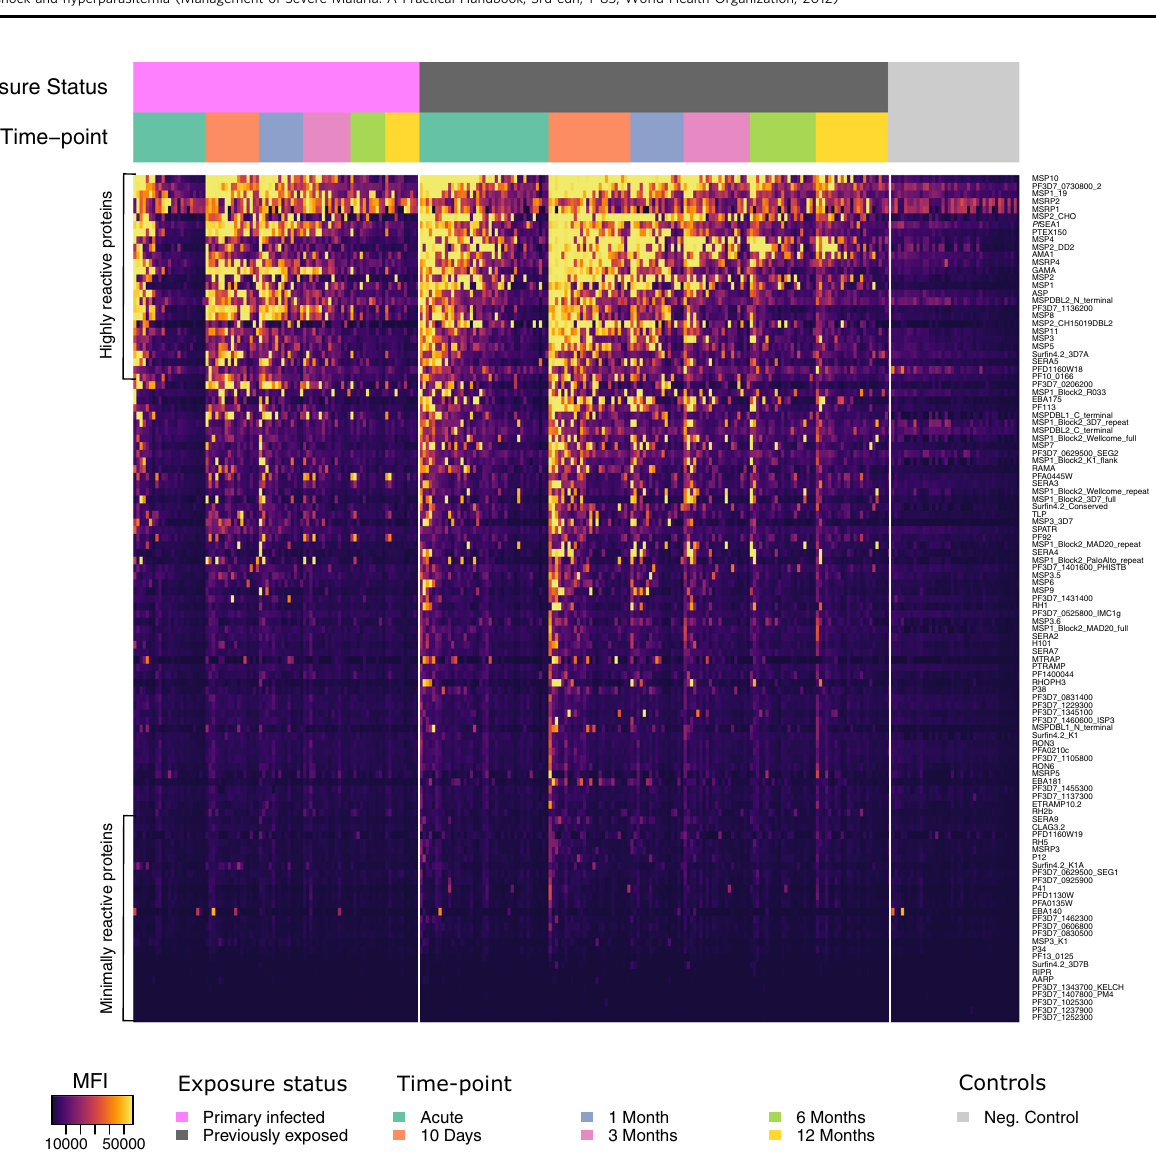
Fig. 1 A heat map of the normalised median fl uorescent intensity (MFI) of the antibody response to each of the 111 antigens included on the KILChip V1.0 Microarray. Rows correspond to individual antigens while columns correspond to individual samples. Antigens are sorted from top to bottom by decreasing average normalised MFI across all samples. Samples are sorted fi rst by exposure status, second by sampling time-point and third by average normalised MFI across all